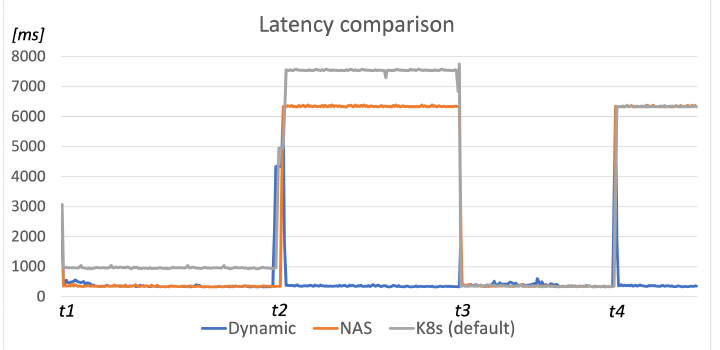
Figure 9. Latency comparison of different scheduling algorithms in automation service scenario